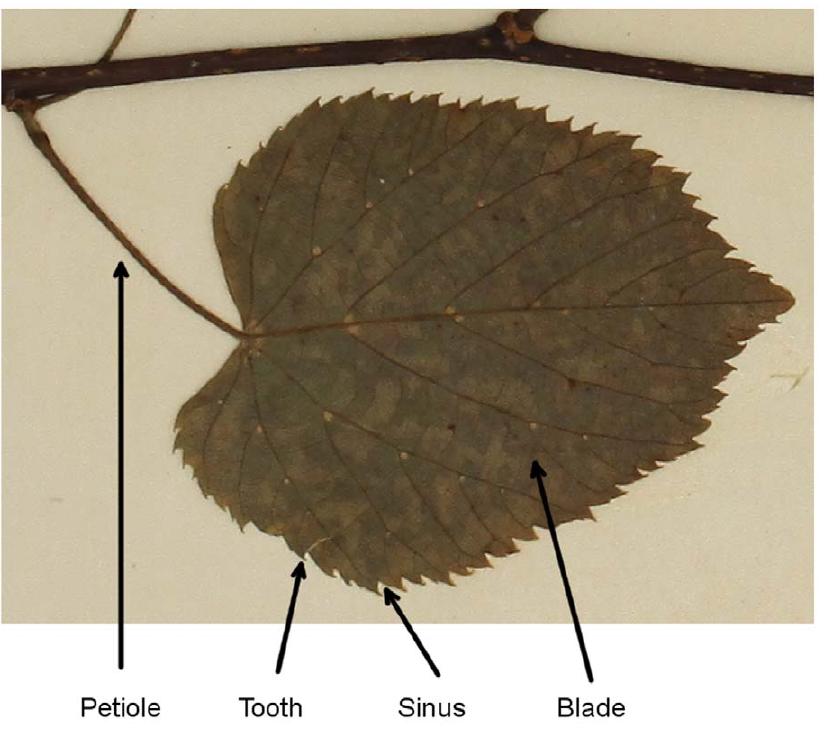
Figure 1. A detail from a typical herbarium sheet. In this example, the leaves are held in place with glue, which are seen here as translucent blobs. Other non-leaf objects appear, such as the stalk at the top. The specimen is mounted on heavy cartridge paper (c. 420 | 270 mm).